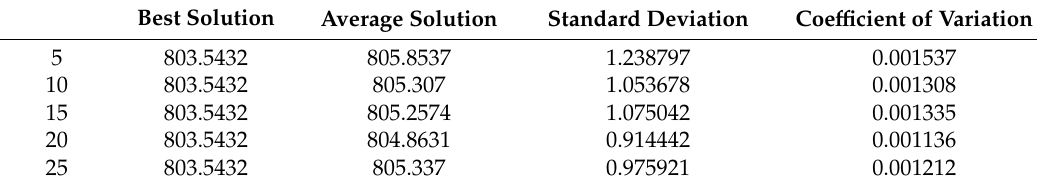
Table 5. Tabu step.